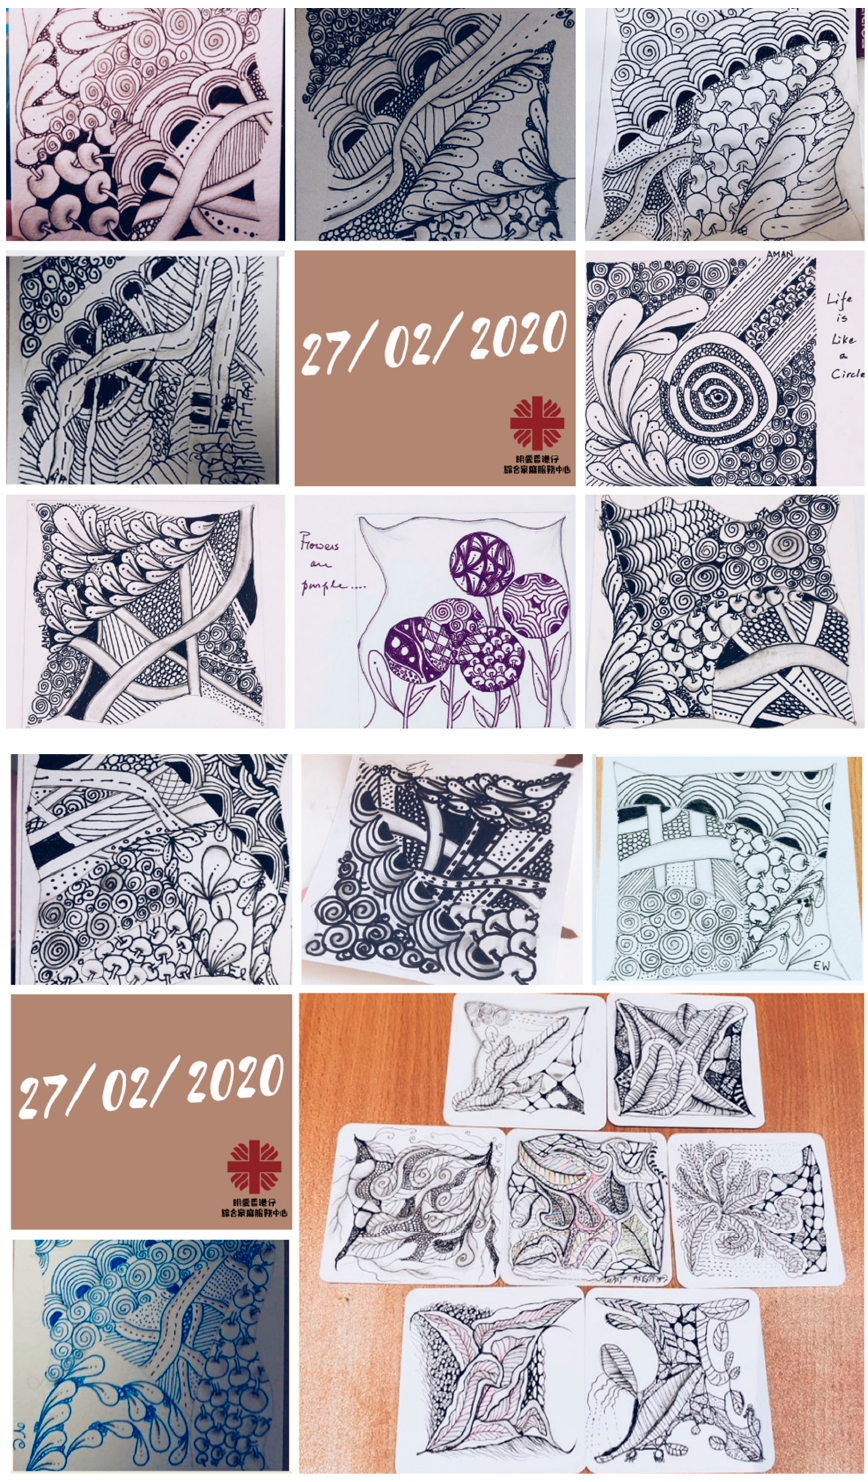
Figure A3. Collages of participants’ Zentangle artwork from different workshops posted by